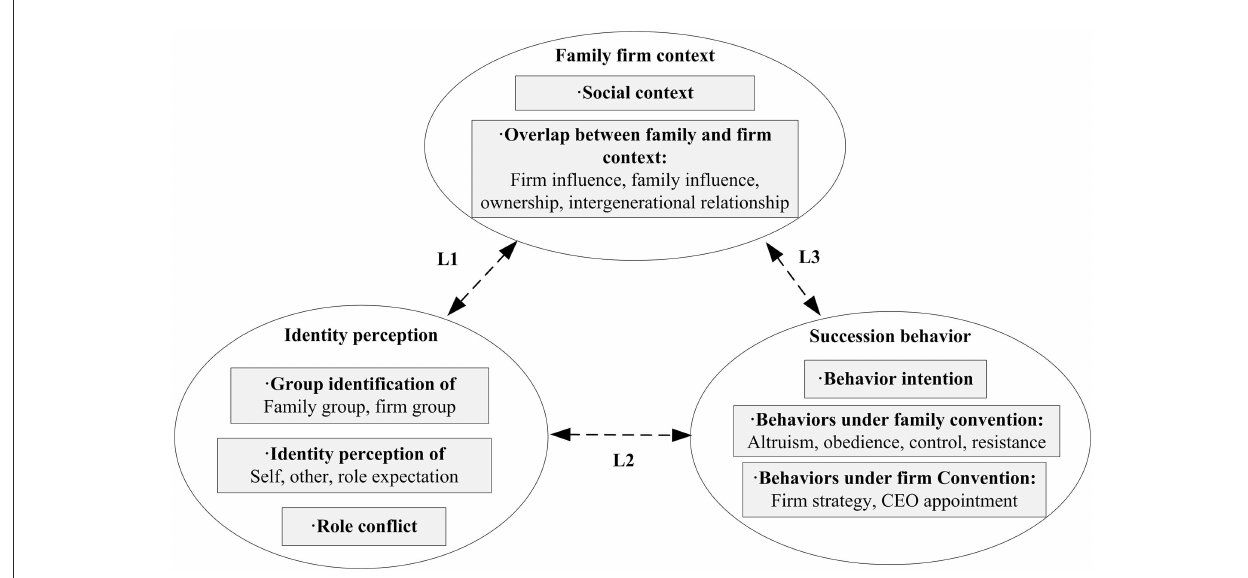
FIGURE1 “Family firm context—identity perception—succession behavior” analytical